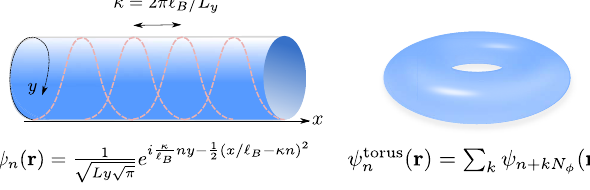
FIG. 2. Boundary conditions considered in this paper, compat- ible with Landau gauge: cylinder (left diagram) and torus (right diagram). The associated single-particle states ψ n ð r Þ are arranged along a one-directional (1D) chain, with the parameter κ ¼ 2 π l =L B y controlling the distance between nearest-neighbor orbitals. both directions (torus). Under periodic boundary conditions in one direction (say, ˆ y ), the single-particle Hilbert space is spanned by the Landau gauge basis wave function labeled by n :